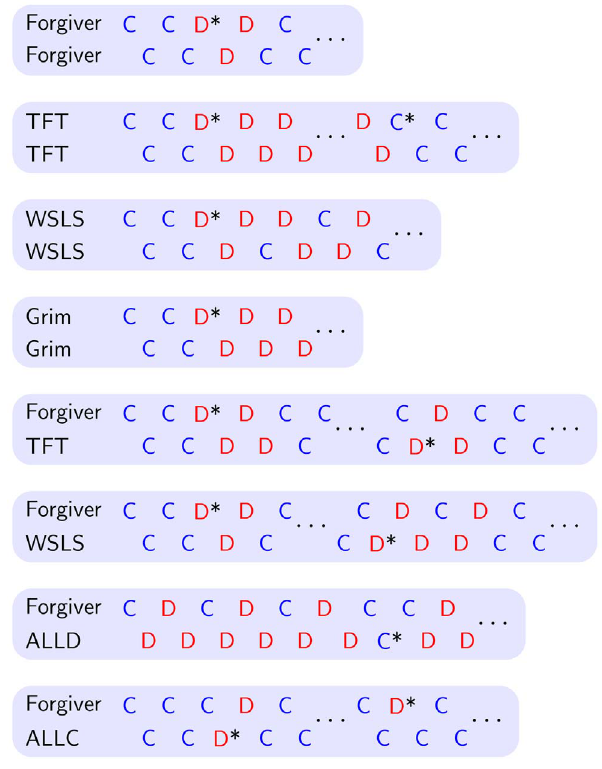
Figure 2. Performance of the conditional cooperators in the presence of noise. An asterisk after a move indicates that this move was caused by an error. When the conditional cooperators are playing against a copy of themselves, Forgiver performs very well as it can recover from an accidental defection within three rounds. Against defection-heavy strategies like Grim and ALLD, Forgiver gets exploited in each second round. Both TFT and WSLS are not error correcting as they are unable to recover back to cooperation after an unintentional mistake. Only another mistake can enable them to return to cooperative behavior. When Grim plays against itself and a single defection occurs, it moves to the defection state with no possibility of returning to